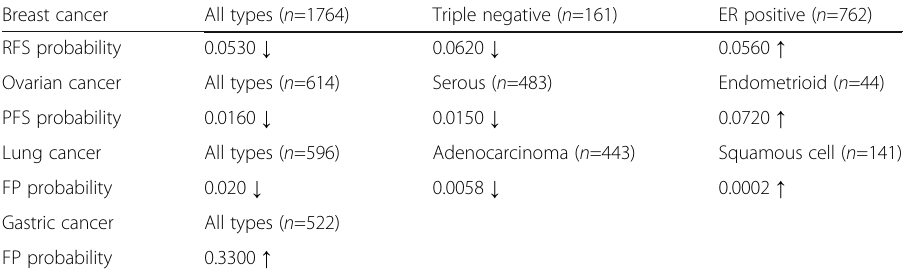
Table 1 Patient outcomes in relation to STAT3 mRNA expression in breast, ovarian, lung and gastric